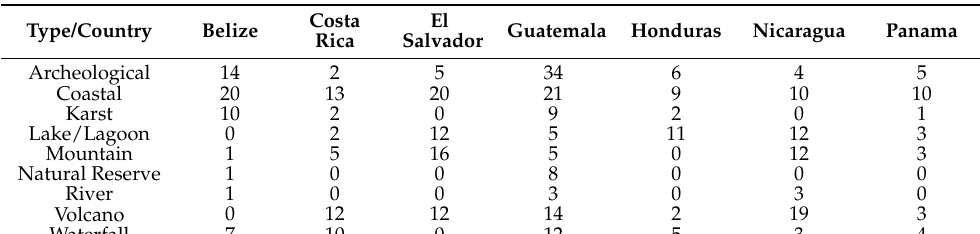
Table 1. Number of the most popular geosites type in Central America by country based on webpages, touristic maps, and internet-based research.